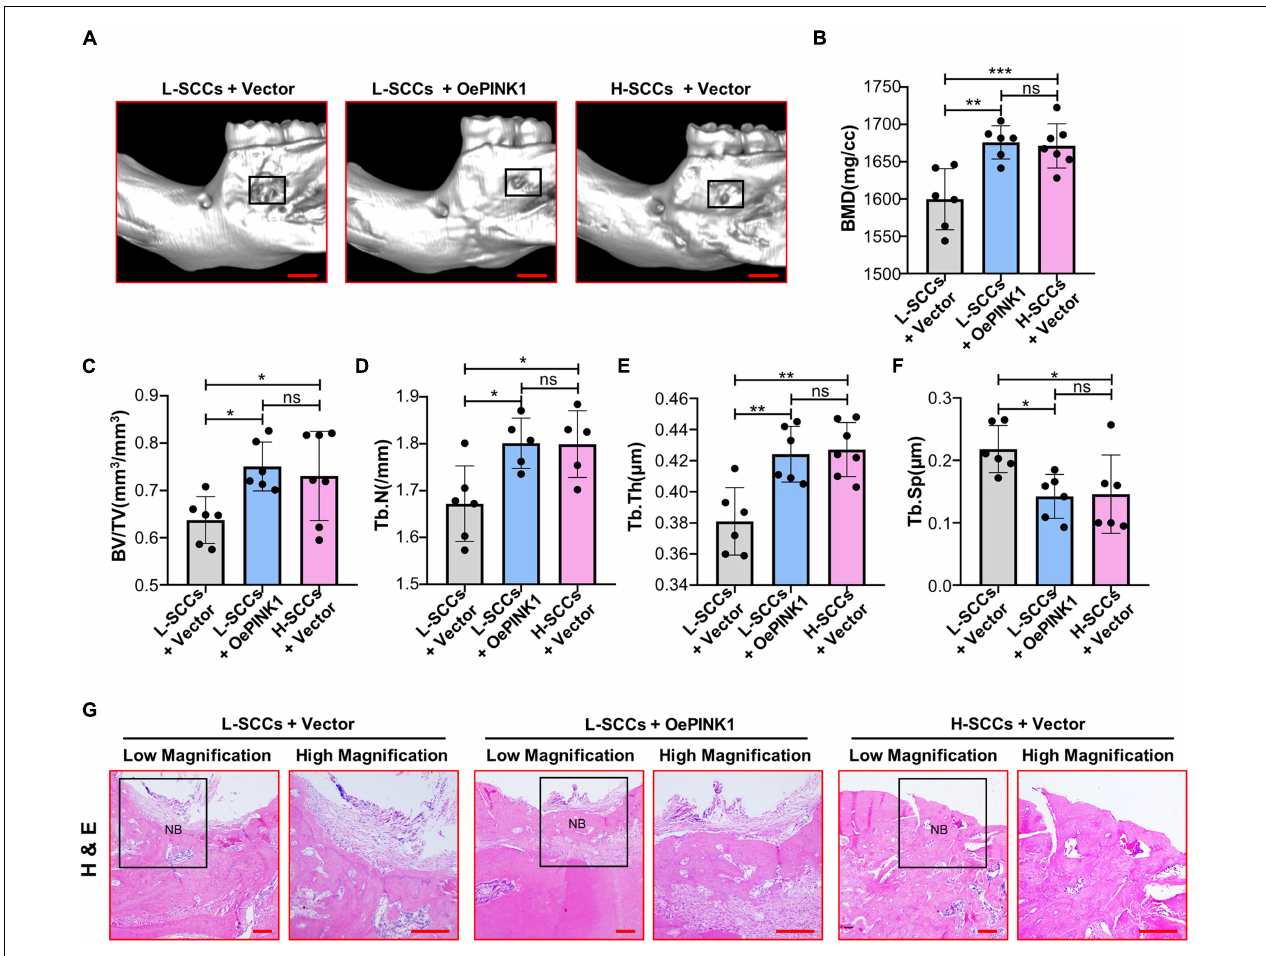
FIGURE 6 | Activation of PINK1/Parkin-mediated mitophagy promoted the osteogenesis of L-SCCs in vivo . (A) The defects filled with cell sheets derived from empty vector-overexpressing L-SCCs, PINK1-overexpressing L-SCCs, or empty vector-overexpressing H-SCCs were explored by a Micro-CT. (B–F) After the defects had been filled in with cell sheets derived from empty vector-overexpressing L-SCCs, PINK1-overexpressing L-SCCs, or empty vector-overexpressing H-SCCs, bone mineral density (BMD), bone volume/total volume (BV/TV), trabecular number (Tb.N), trabecular thickness (Tb.Th), and trabecular separation (Tb.Sp) were evaluated ( n = 5 to 7). (G) Hematoxylin and eosin (H&E) staining was performed 4 weeks after the defects had been filled in with cell sheets derived from empty vector-overexpressing L-SCCs, PINK1-overexpressing L-SCCs, or empty vector-overexpressing H-SCCs. L-SCCs + vector, cell sheet derived from L-SCCs transfected with the empty vector; L-SCCs + oePINK1, cell sheet derived from L-SCCs transfected with the PINK1 overexpression plasmid; H-SCCs + vector, cell sheet derived from H-SCCs transfected with the empty vector; NB, new bone formation. Scale bar, 2 mm for Micro-CT and 100 µ m for H&E staining. * P < 0.05; ** P < 0.01; *** P <